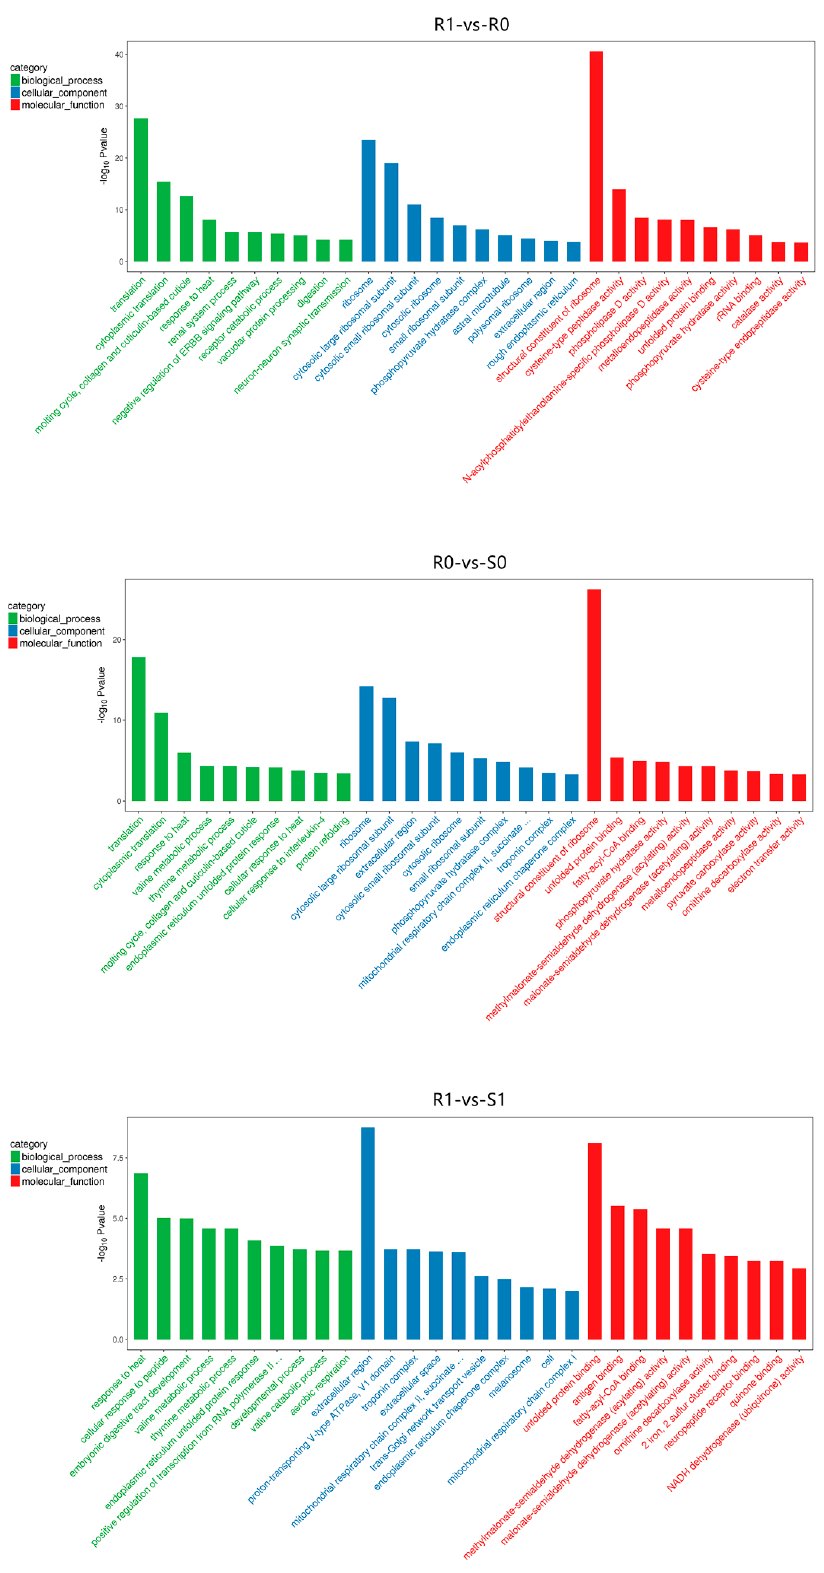
Figure 5. The 30 most significantly enriched gene ontology (GO) terms for the DEGs in the four comparison groups. The GO analysis results are summarized in three categories: biological processes (green), cellular components (blue), and molecular functions (red). The X -axis indicates different GO terms, and the Y -axis represents the corresponding number of genes in each GO